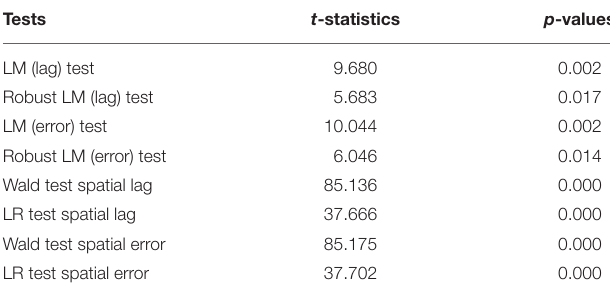
TABLE 3 | Model selection